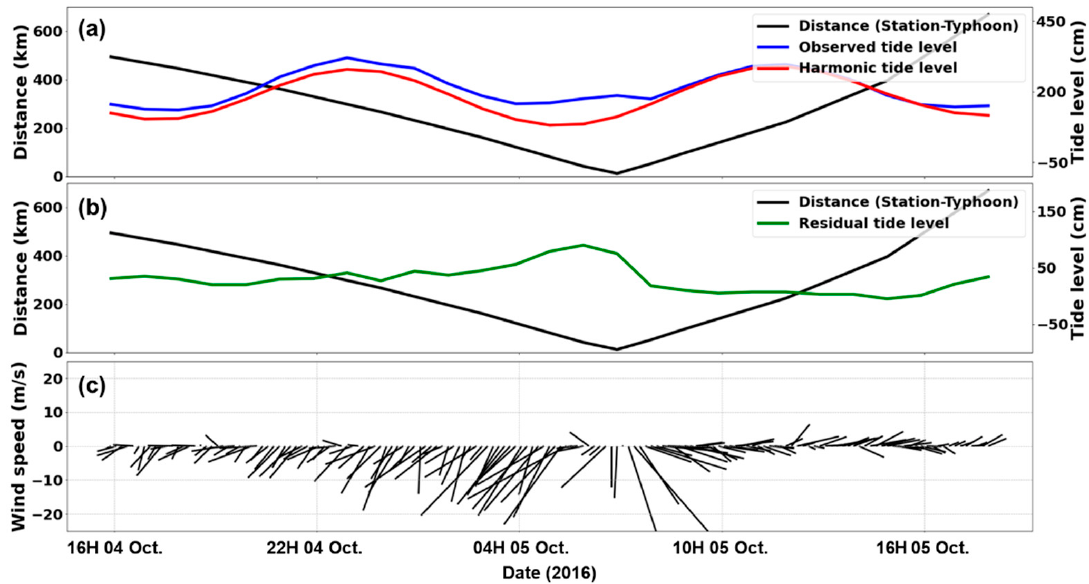
Figure 7. Time-series of observational data from Geomundo tidal station during Typhoon Chaba. ( a ) Astronomical tide, ( b ) residual tide level, and ( c ) wind components, where direction and length indicate wind direction and speed, respectively.